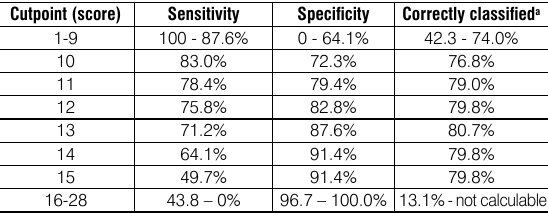
Table 3. Sensitivity and specificity of the EPDS-R.